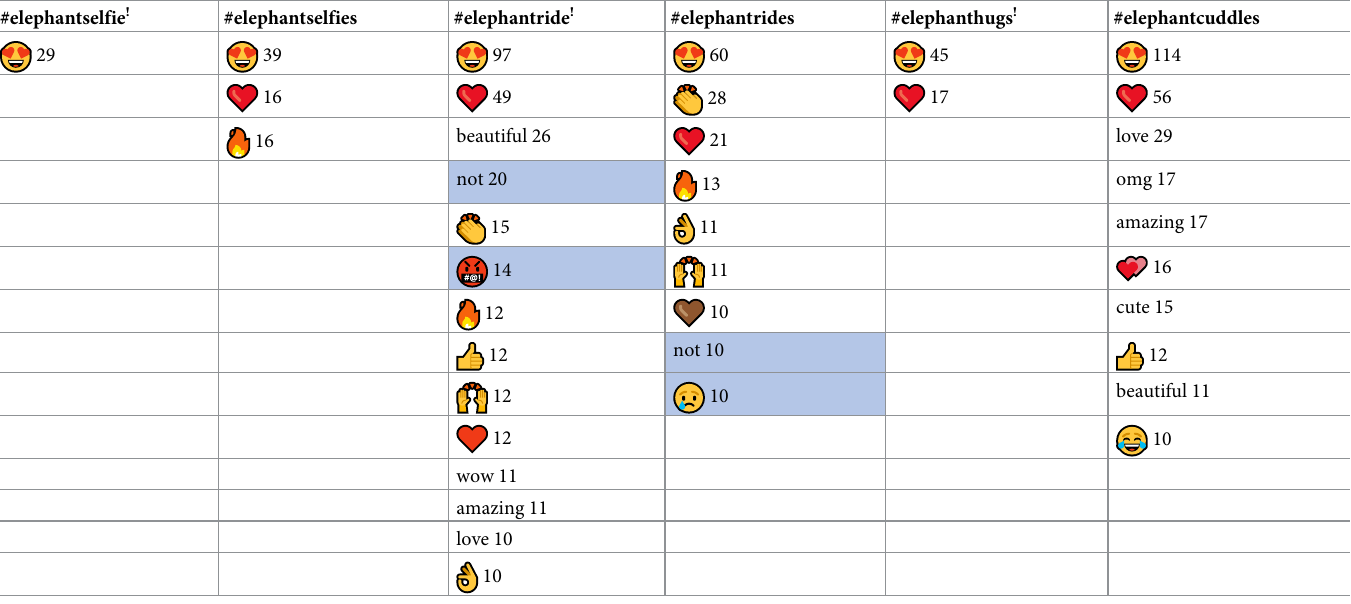
individual platform (for Instagram, see https://help.instagram.com). Compliance, or indeed detection of non-compliance, is, in most cases, at least partly dependent on viewers identifying and flagging inappropriate content (e.g. [57]). In the case of wildlife selfies this is difficult because there is nothing in the image itself to suggest cruelty to nonhuman animals or negative conservation impacts on threatened species; neither is it the case that every image of a smiling human depicted alongside a wild animal is associated with detrimental impacts on animals at either an individual, population, or species level. To understand these issues requires much greater detail on where individual wild animals depicted are sourced from, the conditions that Table 4. Most frequently occurring words in comments on elephant selfie posts using each of six hashtags, where the first of each ‘pair’ of terms—a). #elephantselfie and #elephantselfies, b). #elephantride and #elephantrides, c). #elephanthugs and #elephantcuddles—triggers Instagram’s warning (marked by an!) and the second does not. Data are the frequency of occurrence of words and/or emojis appearing the comments, including only those with a frequency of occurrence of 10 or more. Stopwords were not included, except for the word ‘not’ which may be important as a valence shifter. Words and emojis with negative sentiment scores are shaded in the